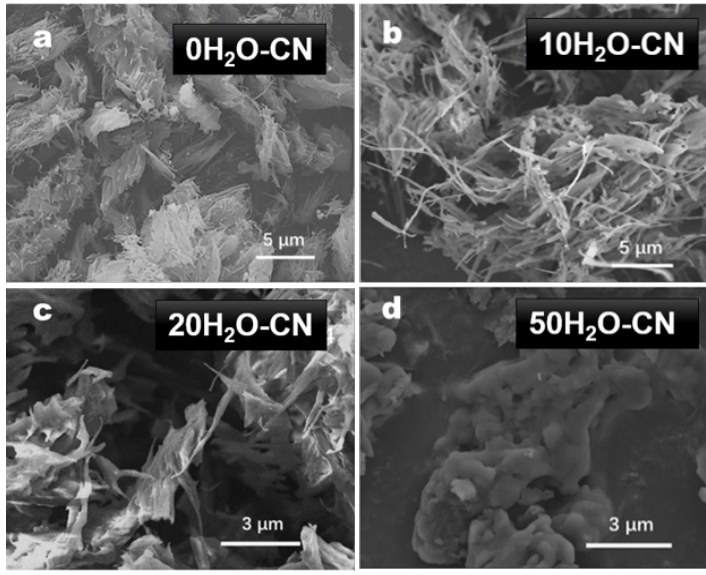
Figure 3. ( a – d ) SEM images for xH 2 O–CN.